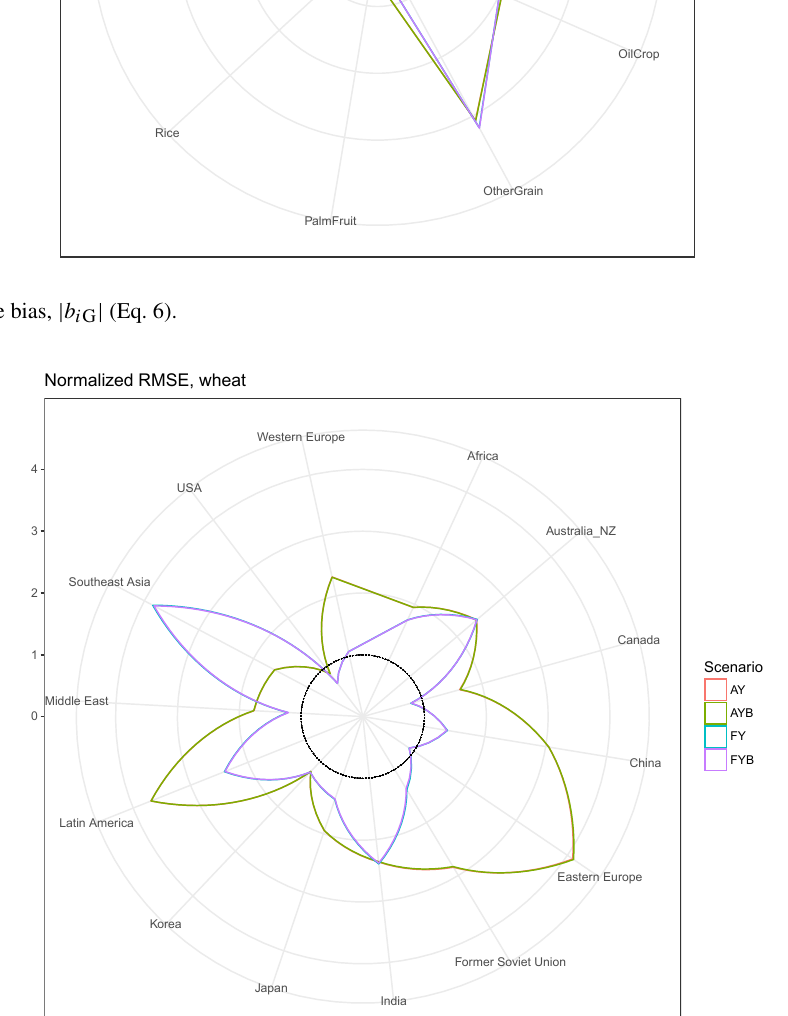
Figure 3. Normalized RMSE, e (cid:48) (Eq. 7), in each region for the land allocated to Wheat. The black circle is at the performance benchmark, ij = 1 (Eq. 11); e (cid:48) e (cid:48) compares RMSE error with the standard deviation of observation for each ij ij